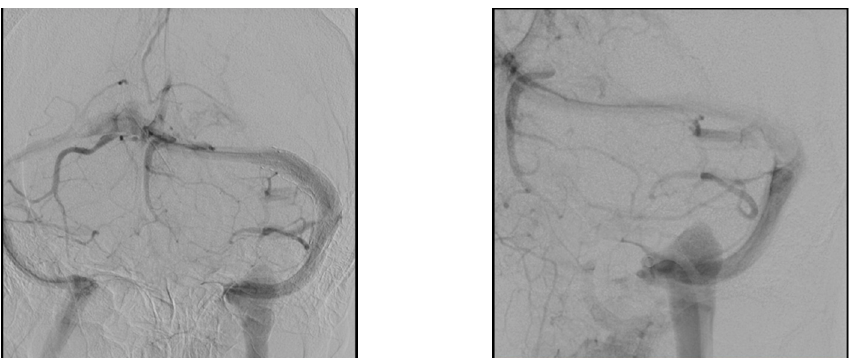
Figure A2. Diagnostic cerebral angiograms—venous phases demonstrating bilateral transverse sinus stenosis.